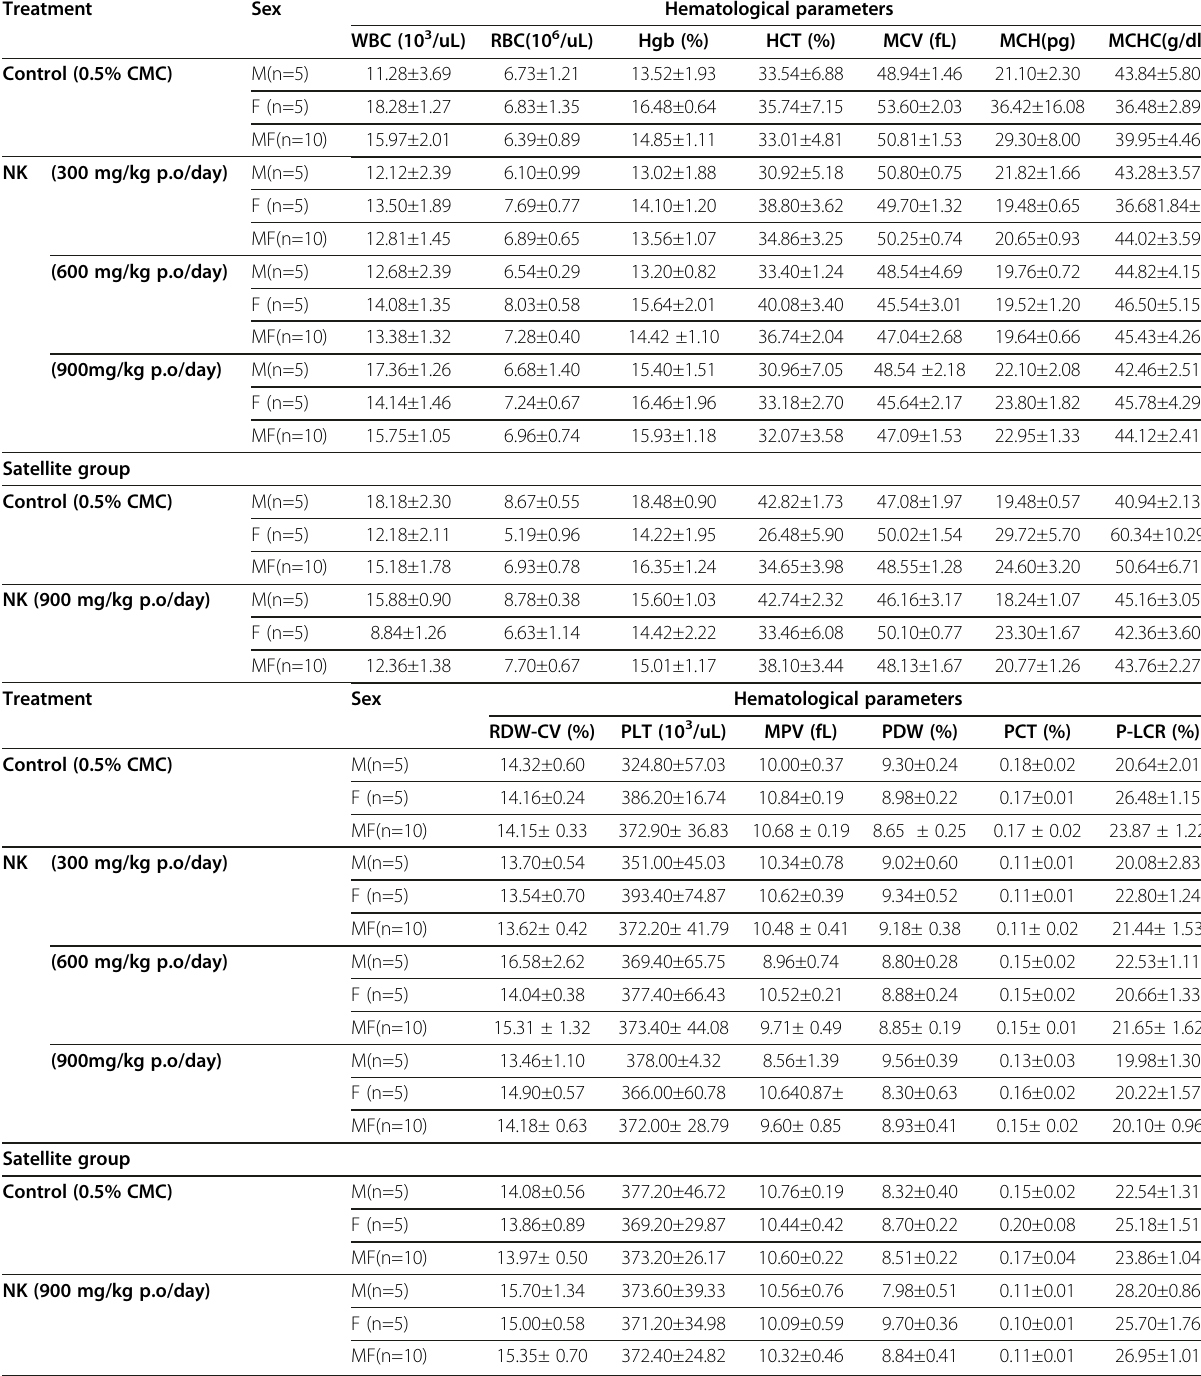
Table 7 Effect of Nuna kadugu on hematological parameters in experimental rats - repeated oral toxicity study